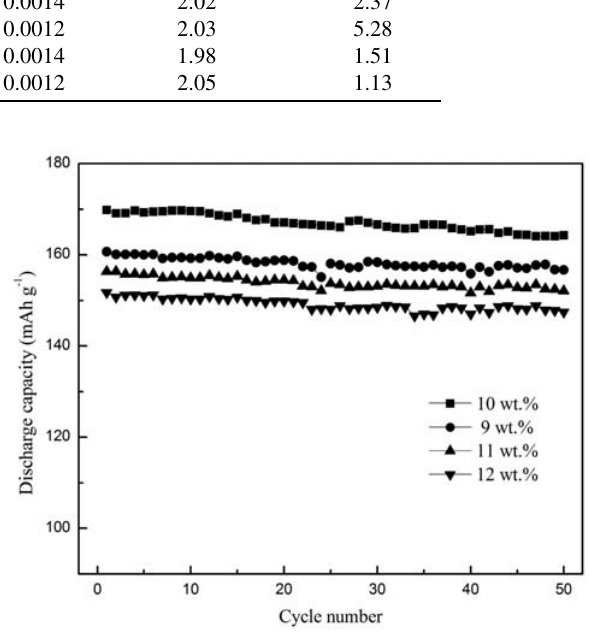
Fig. 6. The cycle performance (discharge capacitie) of different concentrations of GPE based on electrospun TPU/PVDF/PS mem- branes